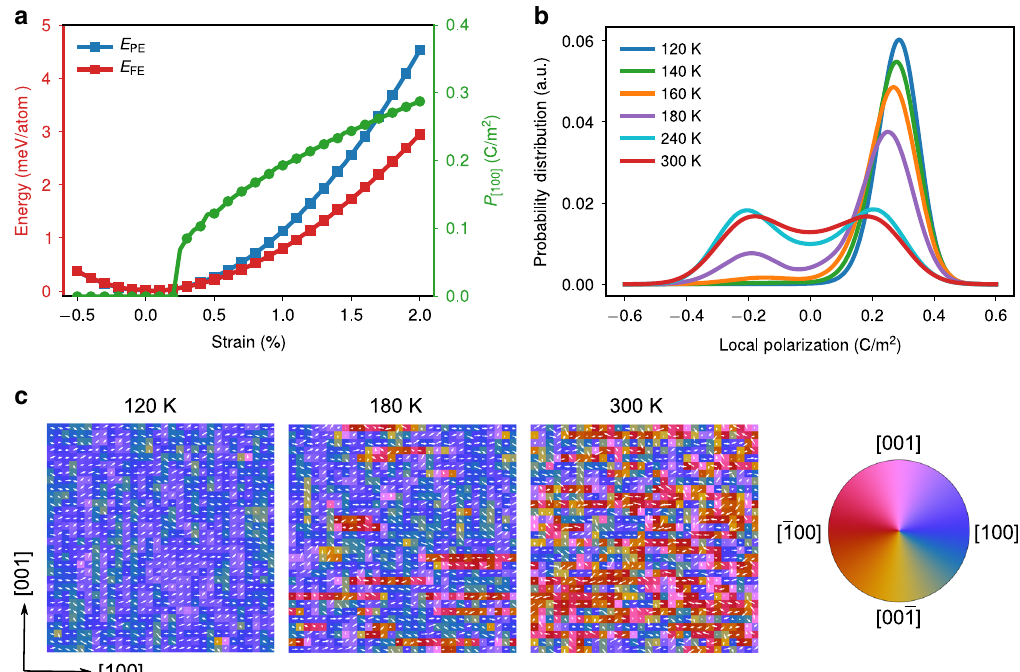
Fig. 4 Density functional theory (DFT) calculations and molecular dynamics (MD) simulations. a Calculated energy of paraelectric and ferroelectric phases and the induced ferroelectric polarization as a function of [100] uniaxial strain in SrTiO 3 from DFT calculations. b Probability distributions of the unit cells adopting a [100]-component of local polarization at various temperatures. c Snapshots of the dipole con fi gurations at different temperatures obtained from MD simulations under 2.0% uniaxial strain conditions. Each white arrow in these graphs represents the local electric dipole within a unit cell, with a background color illustrating the polarization